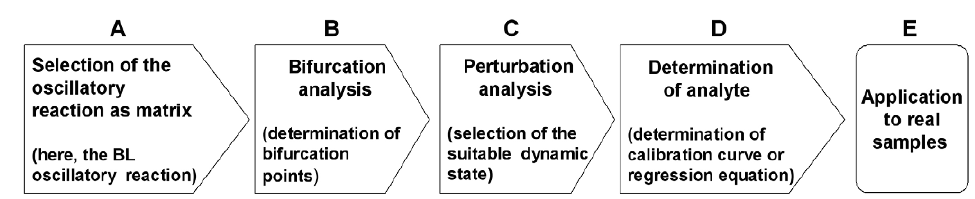
Figure 1. Schematic presentation of all necessary steps for analytical purposes.